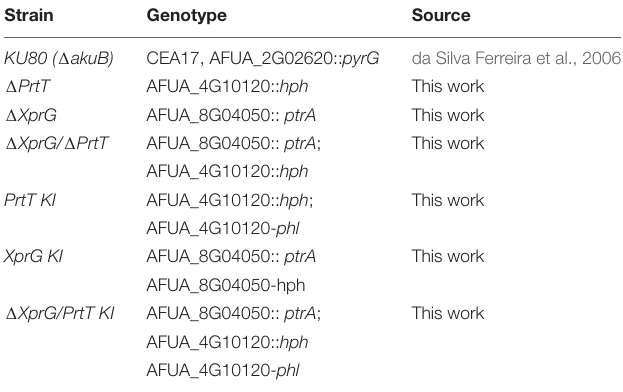
TABLE 1 | Strains used in this